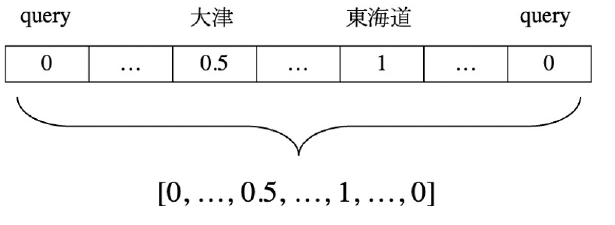
Figure 4. An example of the query embedding. Here, the item was searched and accessed by “ 大 津 ” (Otsu) once and by “ 東 海 道 ” (Tokaido)